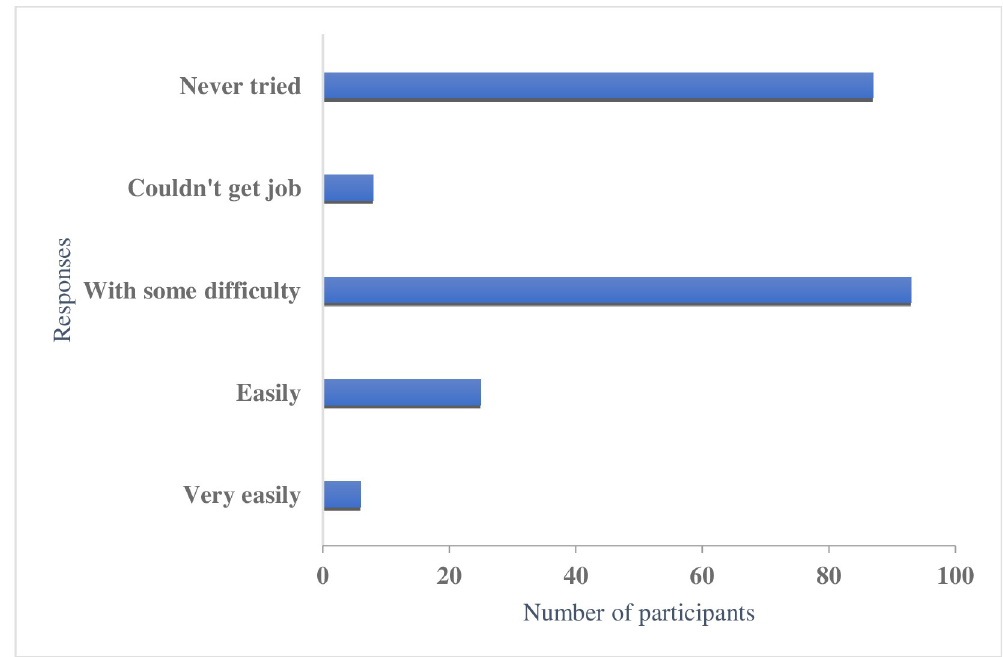
Fig 1. Students’ responses regarding getting work while studying in Australia.